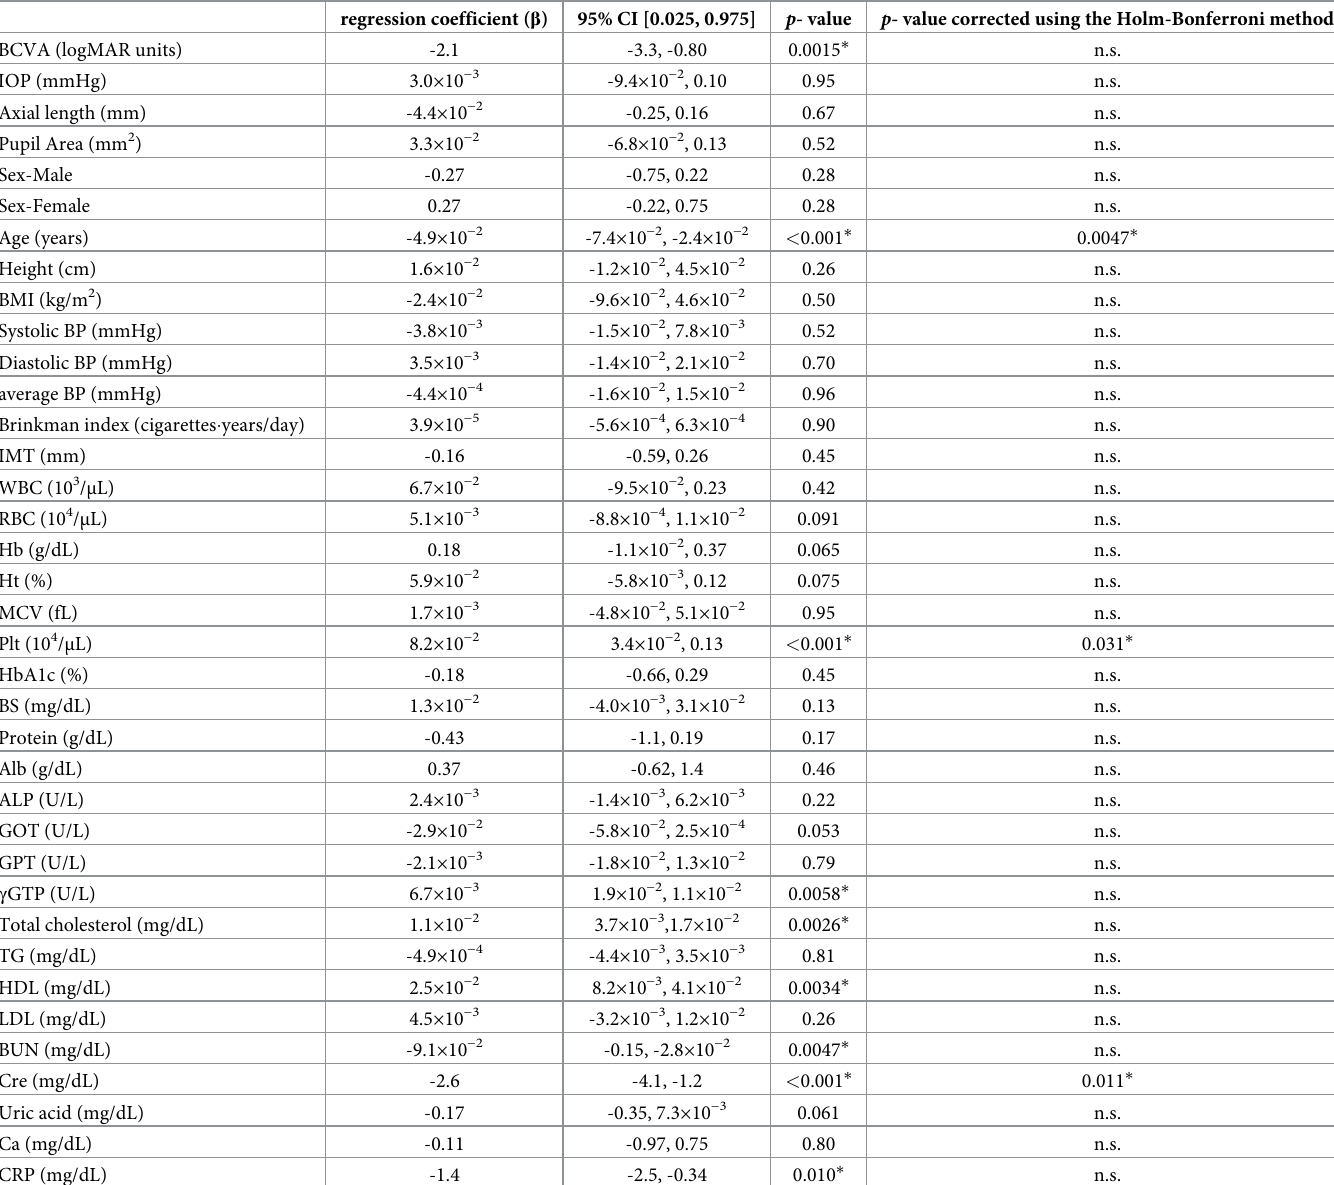
Table 4. Univariable linear mixed effects model regression analysis between amplitudes and explanatory